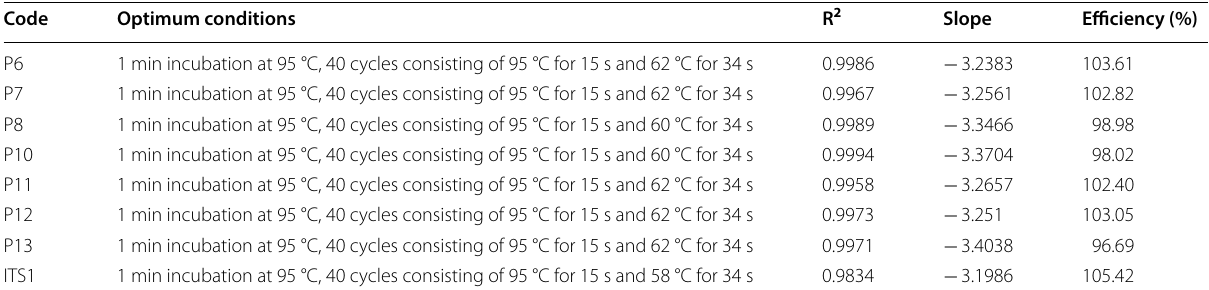
Table 2 Primer characteristics and parameters evaluated by qPCR Code